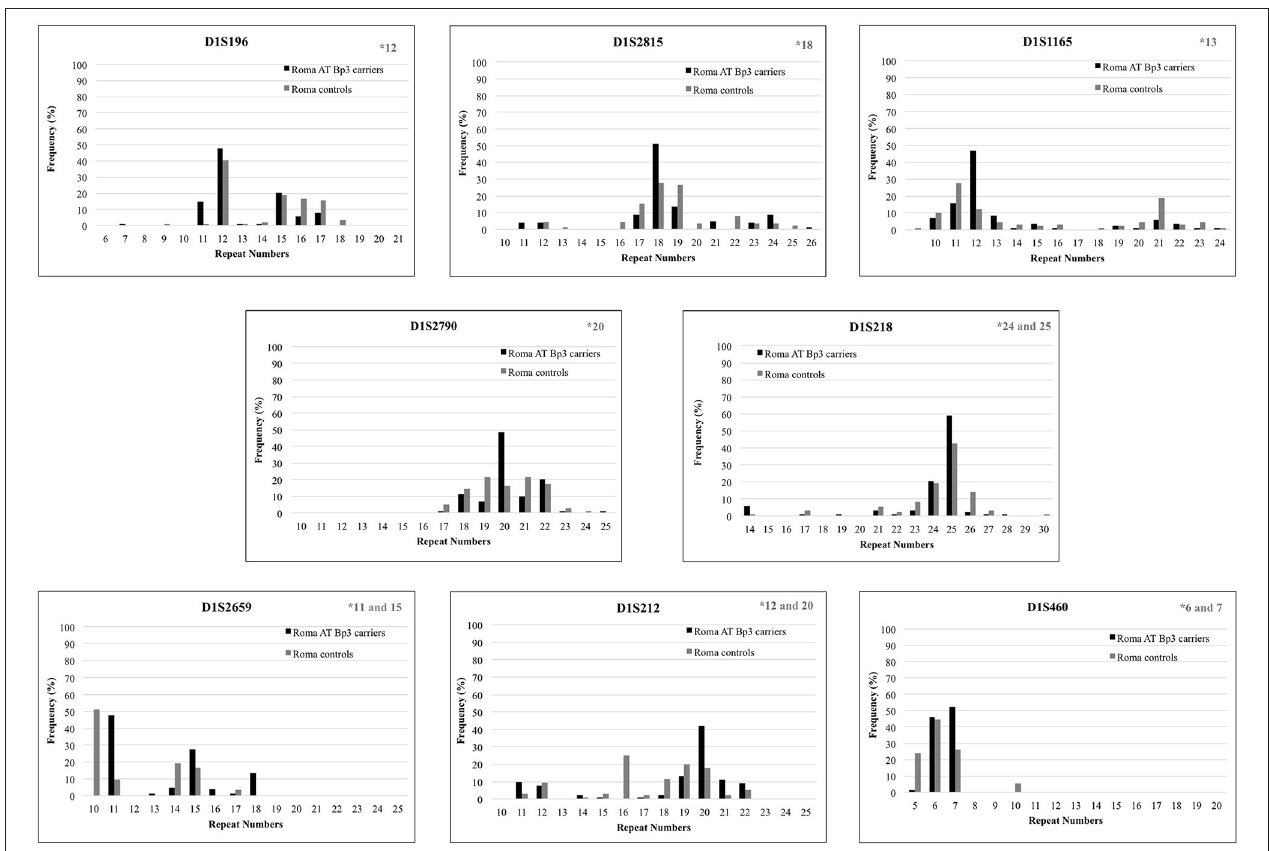
FIGURE 2 | Repeat number variations of eight short tandem repeat markers in Roma ATBp3 carriers and in Roma controls. The most frequent repeat number variations detected at ATBp3 homozygous patients previously are marked in gray in the upper right corner of each